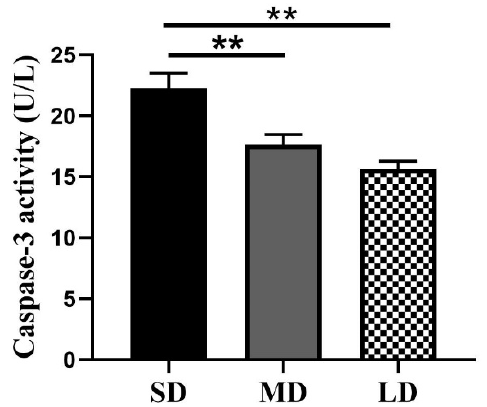
Figure 11. Detection of the caspase-3 activity in Phodopus sungorus under three different photoperiods. Values are means ± SEM. n = 6. SD, short daylight; MD, moderate daylight; LD, long daylight, ** p < 0.01.